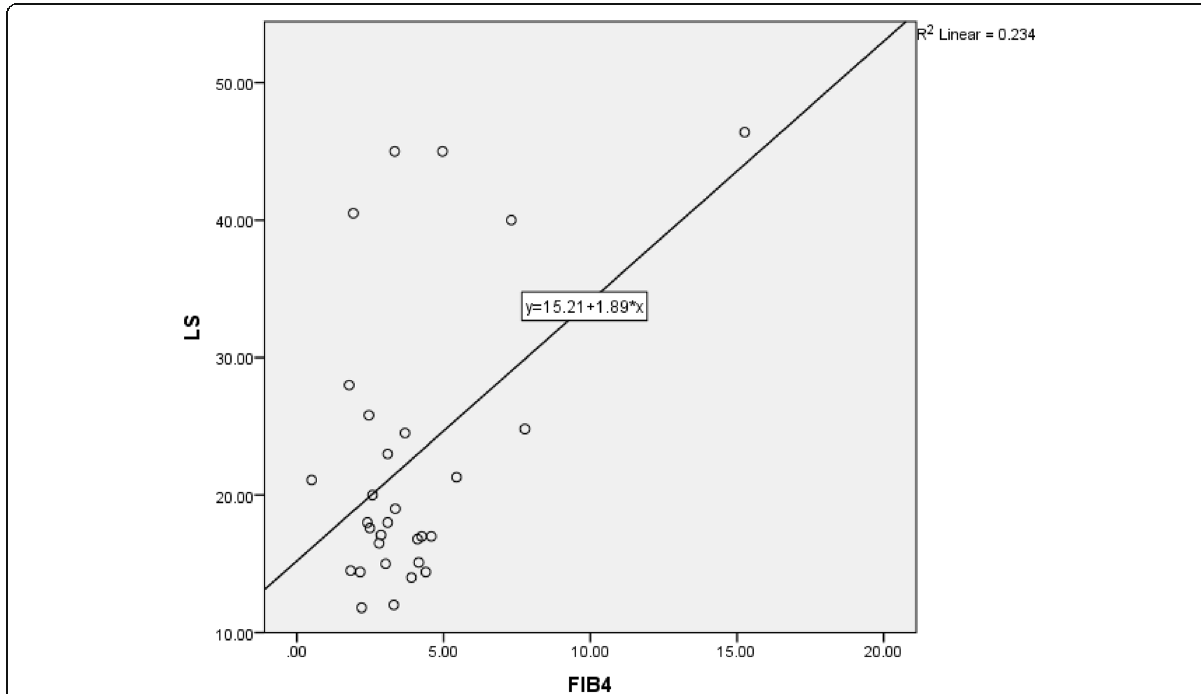
Fig. 4 Scatter plot for the correlation between LS and FIB4